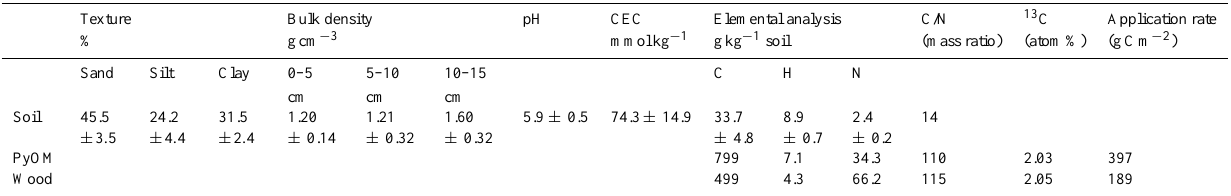
Table 1. Chemical and physical properties of the soil (0–15cm depth) at the field site, and of PyOM and wood. The values presented are means of three replicates ± standard